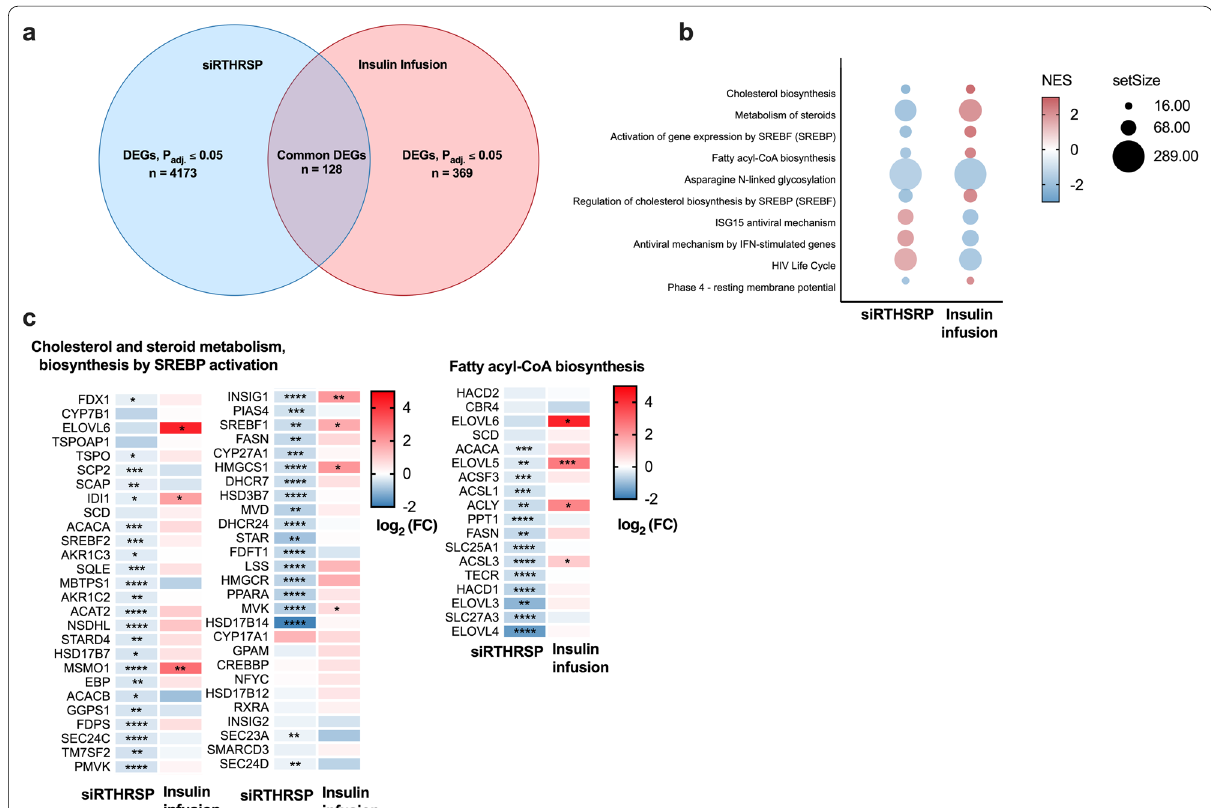
Fig. 3 THRSP silencing and insulin targeted common pathways. a Venn diagram indicates the number of significantly altered genes in THRSP silencing in blue, hyperinsulinemia in red and overlapping significantly altered genes in the middle. b GSEA Reactome analysis was conducted from the transcriptome of human AT obtained during hyperinsulinemic clamp. Pathways affected by insulin infusion were compared to the pathways altered by THRSP silencing. There was 10 common pathways inversely altered. NES score is indicated by color and the set size by symbol size. c Significantly altered common metabolic pathways’ gene expression. Statistical significance is denoted as *P adj ****P adj <